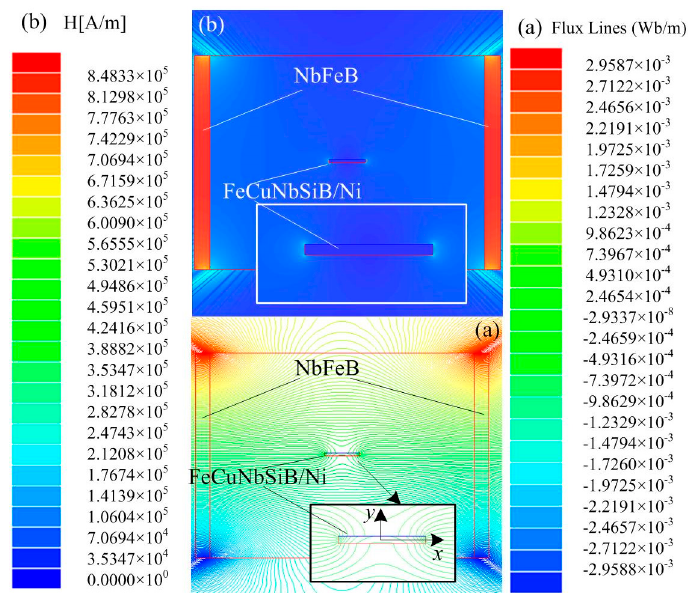
Figure 4. When the layers of the FeCuNbSiB ribbon L = 1, the distribution diagrams of ( a ) flux lines and ( b ) magnetic field of the FeCuNbSiB/Ni laminate.